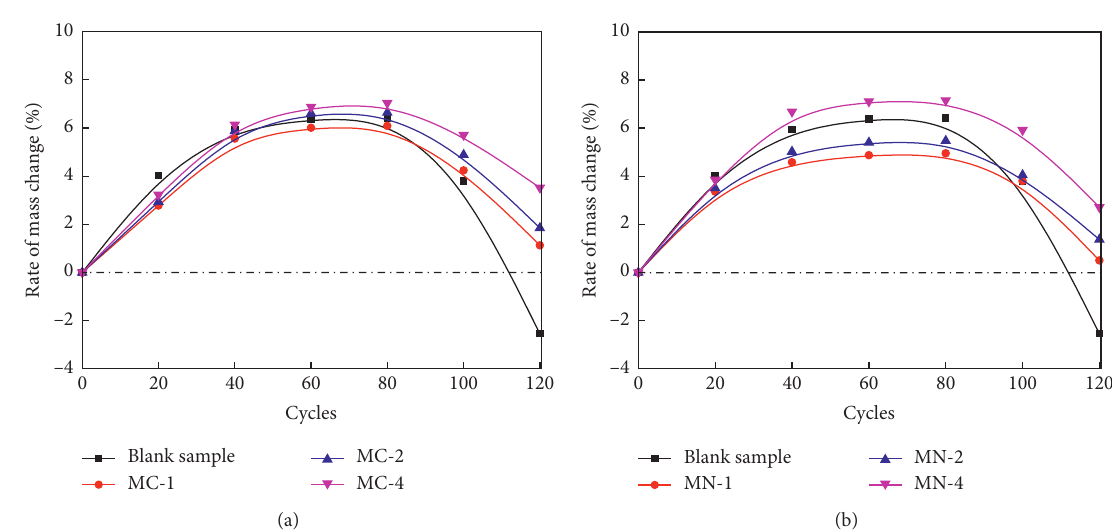
Figure 10: Mass change rate of mortar under dry-wetting cycles. (a) Mortar with N-LDH. (b) Mortar with